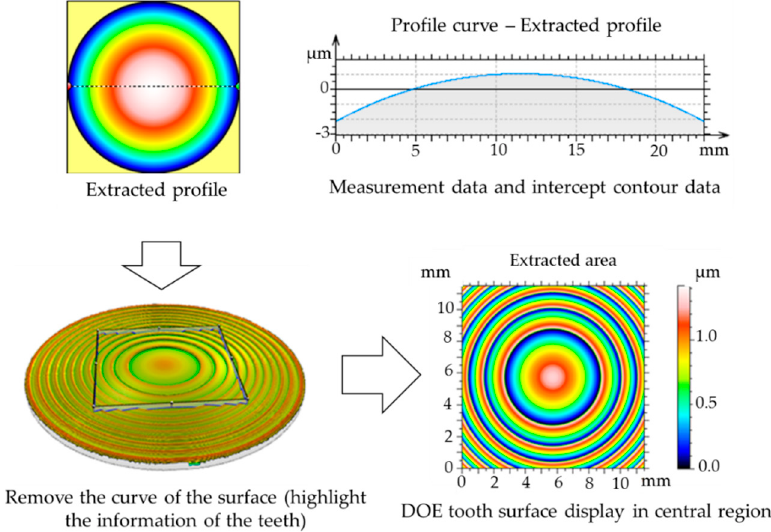
Figure 13. Error of ( a ) DOE pitch measurement; ( b ) tooth height measurement.